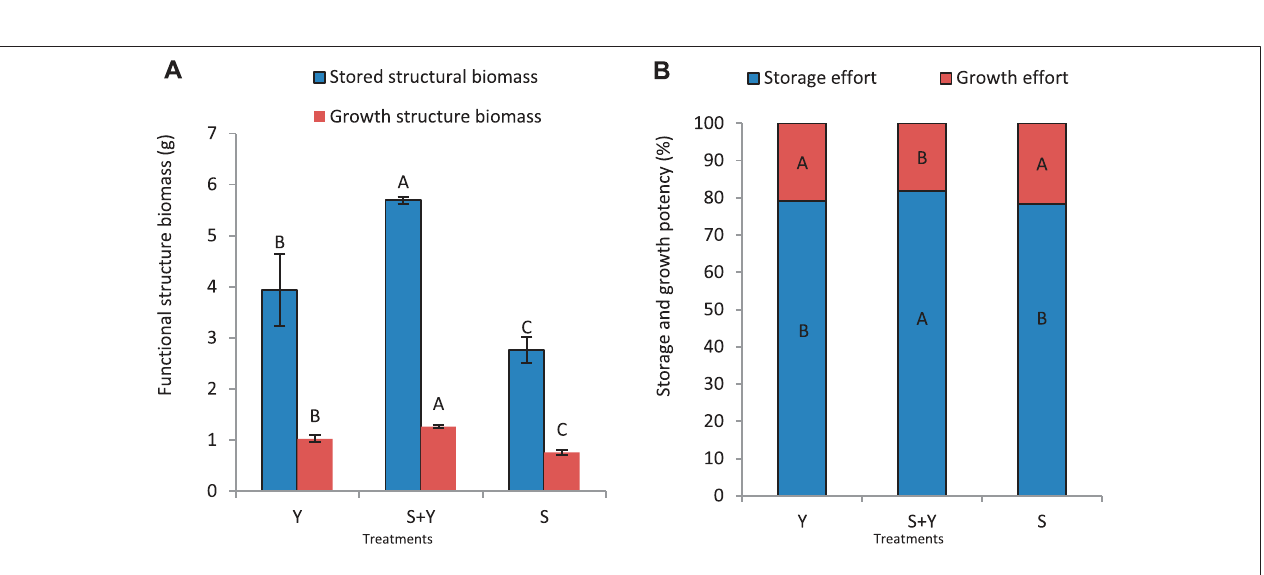
Frontiers in Environmental Science |